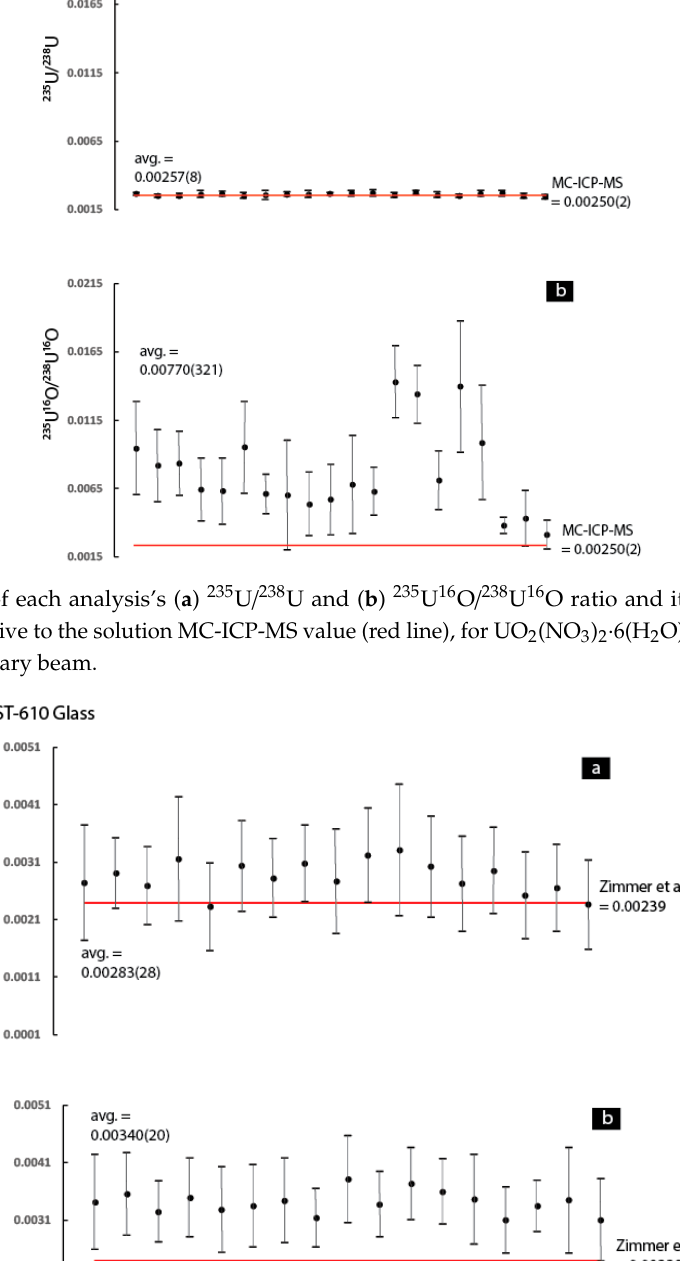
Figure 9. Plot of each analysis’s ( a ) 235 U / 238 U and ( b ) 235 U 16 O / 238 U 16 O ratio and its associated 1 σ uncertainty, for the NIST-610 glass. The reference 235 U / 238 U ratios (red line) for the NIST-610 glass is the average LG-SIMS value reported in [22]. Uncertainty of the value in [22] is considerably lower than the NanoSIMS results and is therefore not shown here.